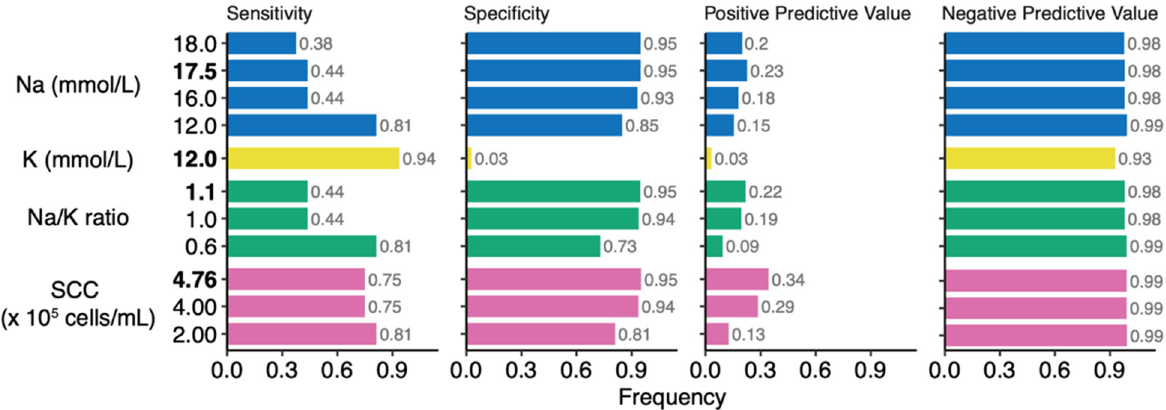
Figure 5. Sensitivity, specificity, positive predictive value, and negative predictive values of the different biomarkers and thresholds in classifying samples as having been produced by a breast with clinical mastitis.